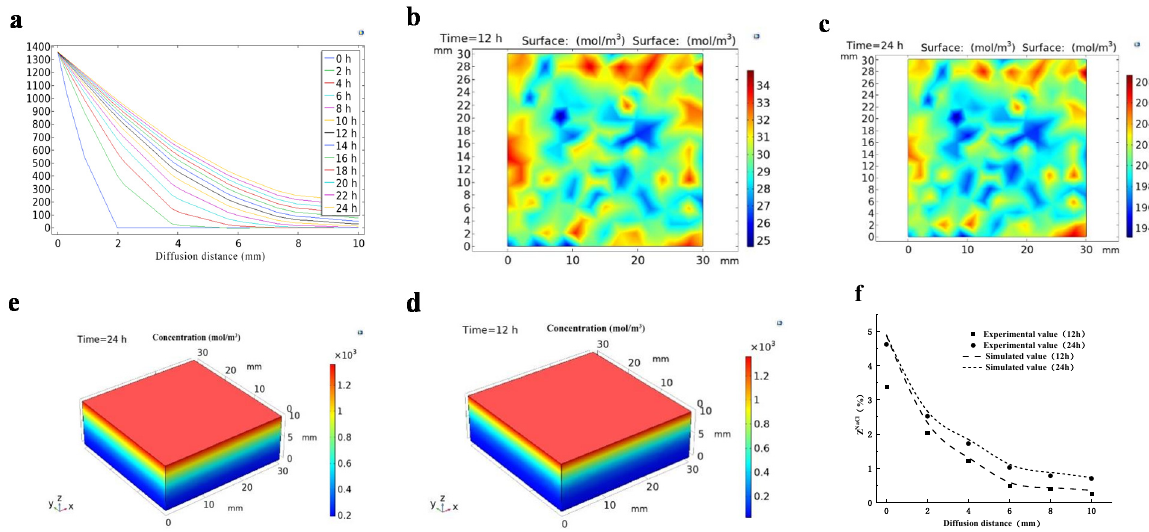
Figure 4. The unidimensional ( a ), 2D ( b , c ), 3D ( d , e ) simulation diagram of NaCl diffusion at different curing times with 4% xylitol, and the experimental vs. simulated values of NaCl content with 4% xylitol in pork tenderloin ( f ).